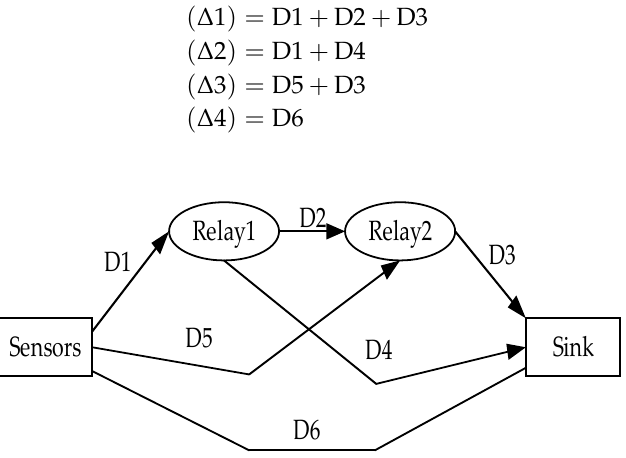
Figure 4. Routing Node Arrangement Diagram of MHRP Protocol.